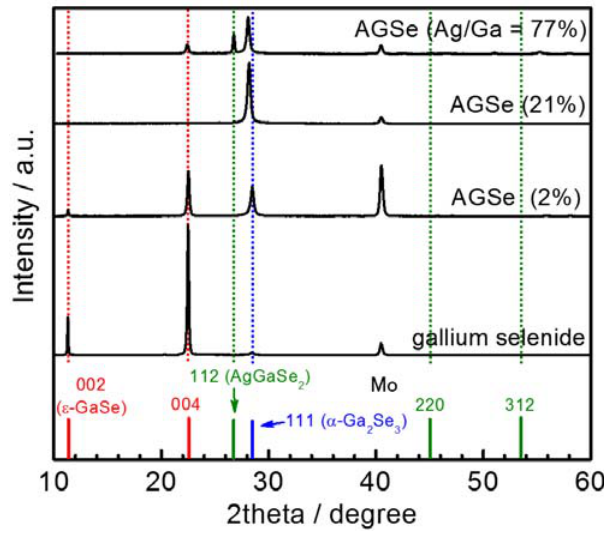
Figure 6. XRD patterns for gallium selenide and AGSe films prepared with various Ag/Ga ratios. Reference peak positions are shown. ICSD numbers of ε -GaSe, AgGaSe2, and α -Ga2Se3 are #2002, #52570, and #35028, respectively.